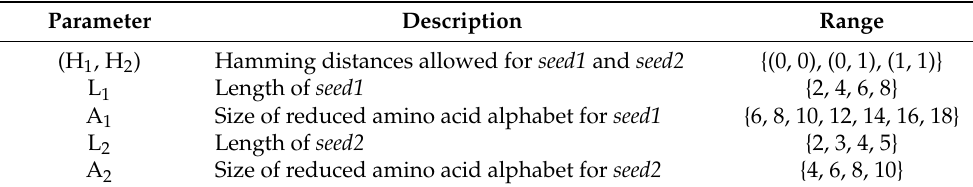
Table 3. TSSS parameter ranges.